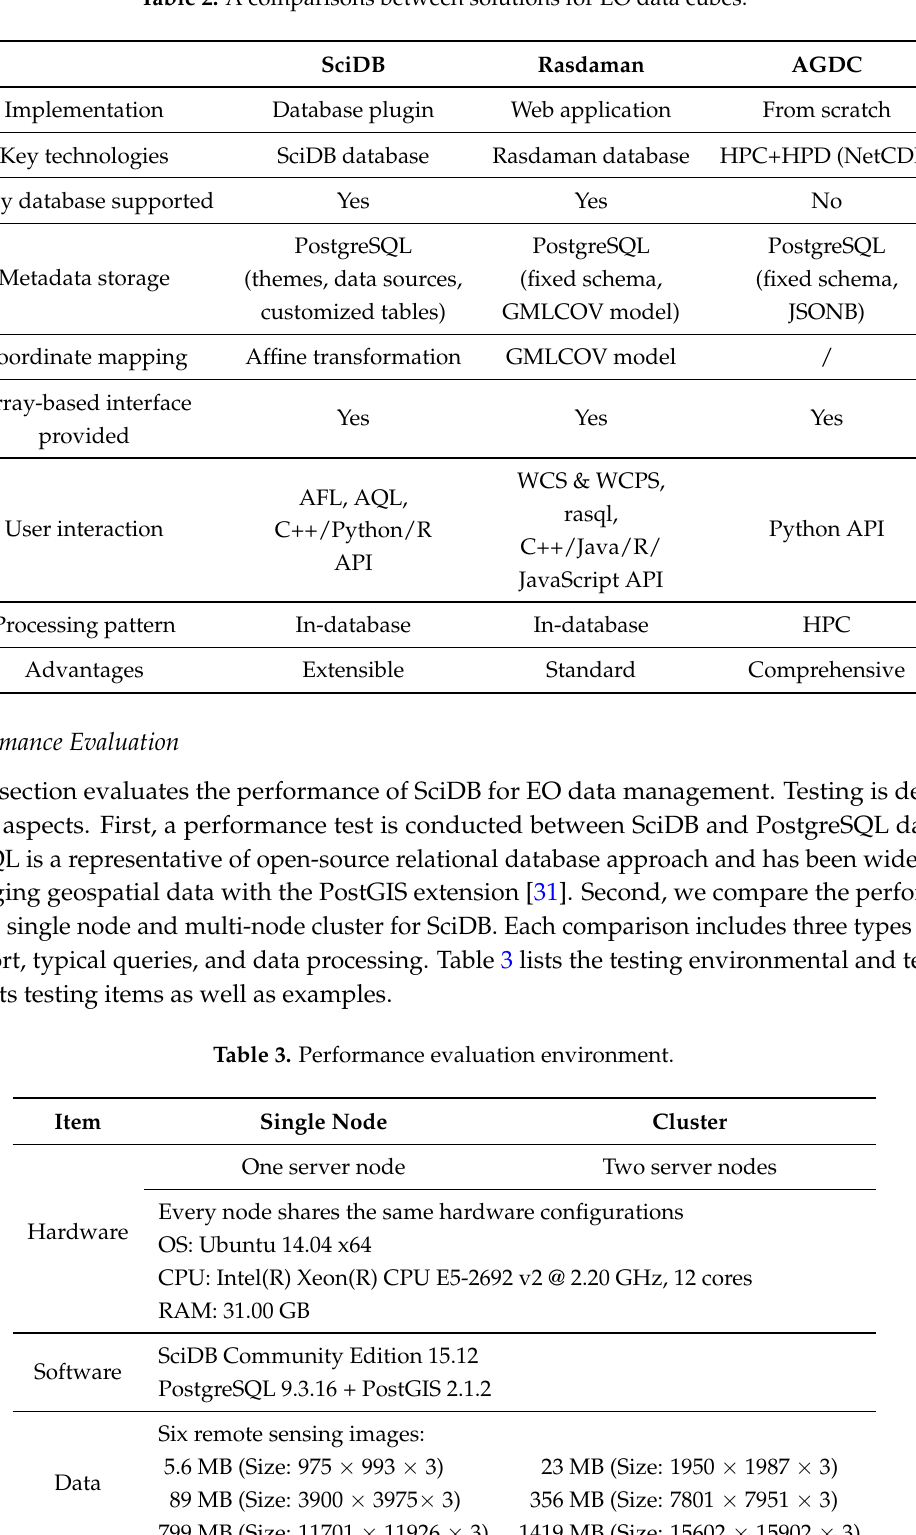
Table 2. A comparisons between solutions for EO data cubes.